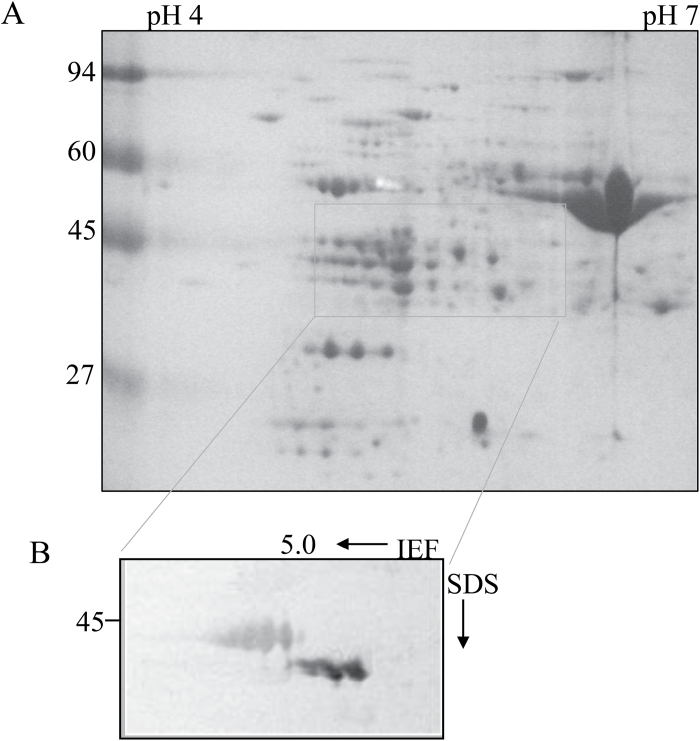
Two-dimensional analysis of GS isozymes in wheat leaves. (A) Two-dimensional gel of proteins extracted from the wheat leaf; stained with Coomassie Blue R250. The rectangle shows the region putatively containing GS spots. (B) Two-dimensional immunoblots of GS subunits in wheat leaf. IEF, isoelectric focussing. Leaf proteins (50 μg) were separated by two-dimensional electrophoresis, and the region thought to contain GS (larger than the rectangle) was electroblotted and probed with antibodies against tobacco GS2.